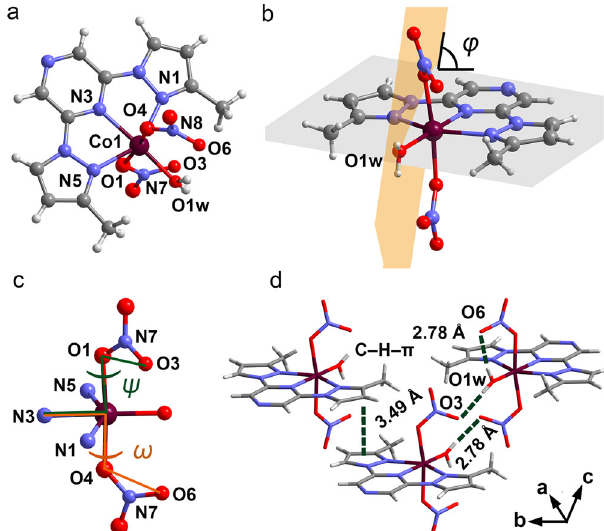
Fig. 1 Molecular structure and interactions of complex 1. a Molecular structure of crystal 1 recorded at 190 K. b The plane of the coordinated water molecule and the molecular plane form the dihedral angle φ with a value of 83.99°. c The dihedral angles ψ and ω , which are related to nitrates, are 133.54° and 159.65°, respectively. d The entire structure is mainly stabilized by O – H···O hydrogen bonds and C – H – π interactions; the water molecule acts as a hydrogen bond donor. Maroon, Co; gray, C; blue, N; red, O; light gray,